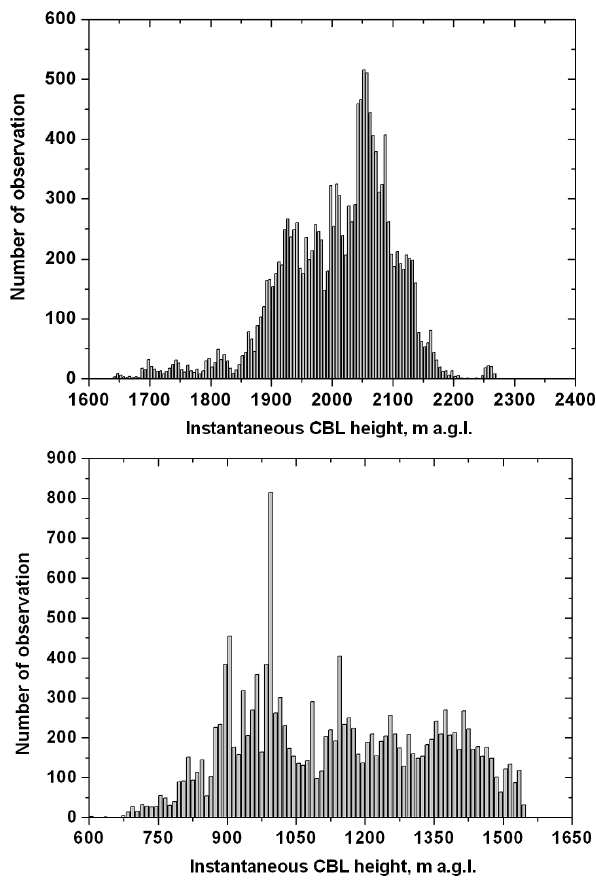
Fig. 6. Frequency distribution of the instantaneous CBL height de- rived by the HWT-based method for Case I (top) and Case II (bot-